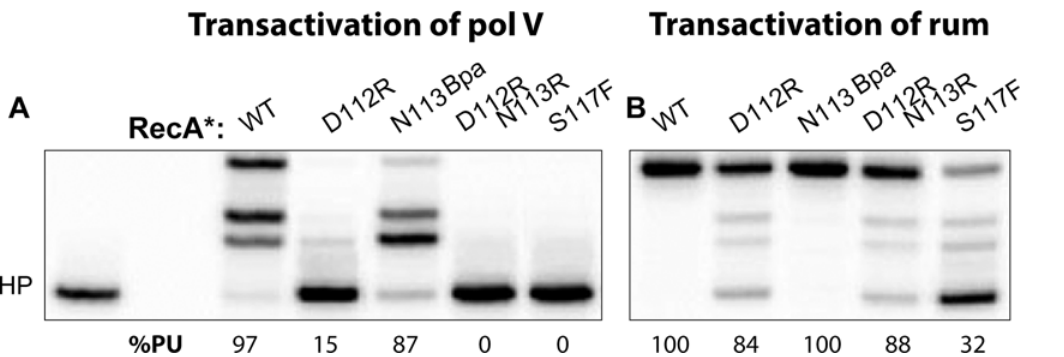
Fig 7. RumA 0 2 B can be activated by all RecA variants. Transactivation reaction was carried out on 3-nt overhang hairpin for UmuD 0 2 C (A) and RumA 0 2 B (B). RecA * (400 nM) was preformed on 30 nt ssDNA then mixed with UmuD 0 2 C or RumA 0 2 B (400 nM each) and incubated for 30 mins at 37°C. Unlike UmuD 0 2 C (A), RumA 0 2 B can be activated by RecA variants D112R, D112R N113R, and S117F (B).